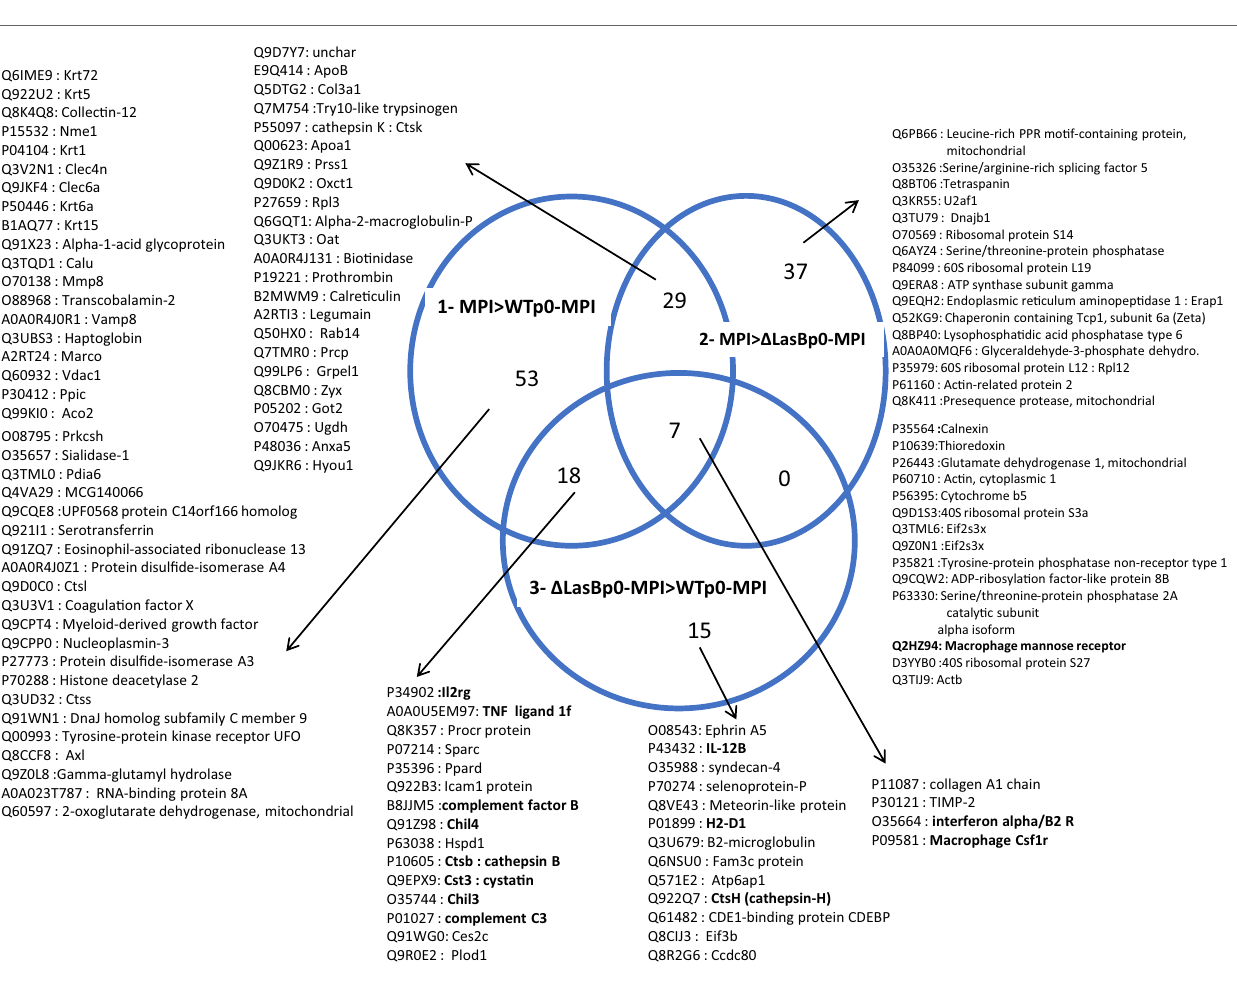
FigUre 8 | List of MPI proteins extracted from the Venn Diagrams represented in Figure 7B (see full list in Figures S5–S10 in Supplementary Material). For each area of the Venn Diagram circles, the proteins identified within the hits are represented, with their Uniprot accession number. NB: the difference between the number of hits and the number of proteins represent entities with more than one Uniprot identifier; For example, P34902 and Q3UPA9 are two different “hits” representing the same protein (IL2rg, at the intersection of circles 1 and 3), but only P34902 is